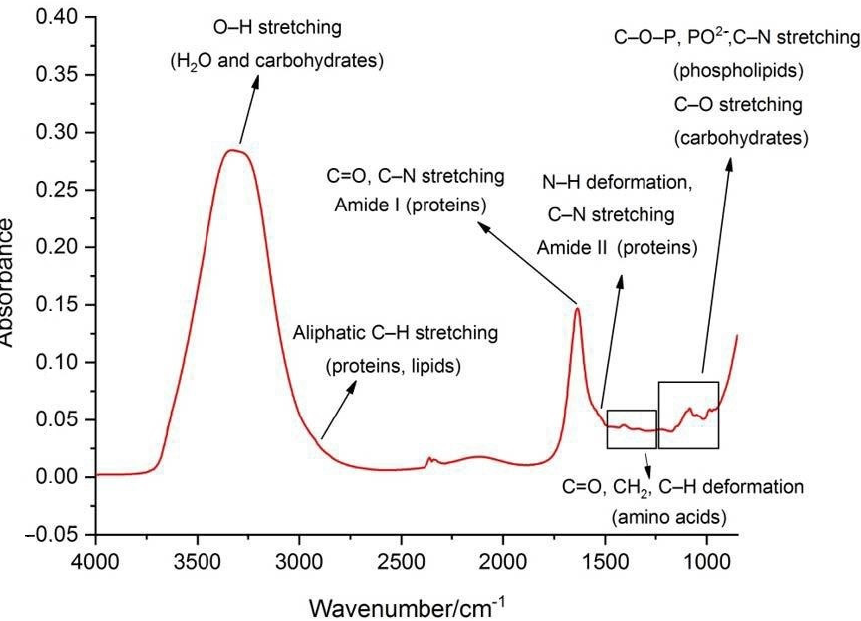
Figure 3. Characteristic FTIR-ATR spectrum of the honey bee hemolymph (spectral range: 4000–600 cm − 1 ) with assignation of major underlying molecular vibrations. (Reprinted with permission from ref. [33]).